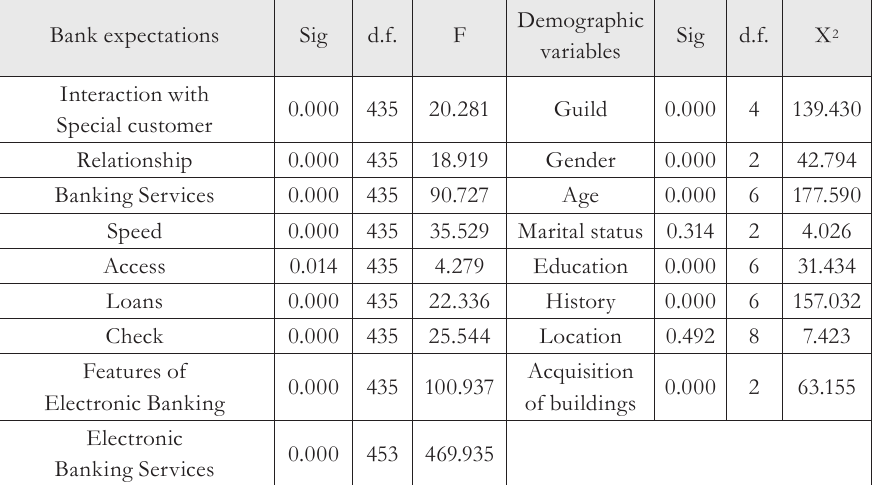
Tab. 6 - Testing independency of the identified clusters (Source: